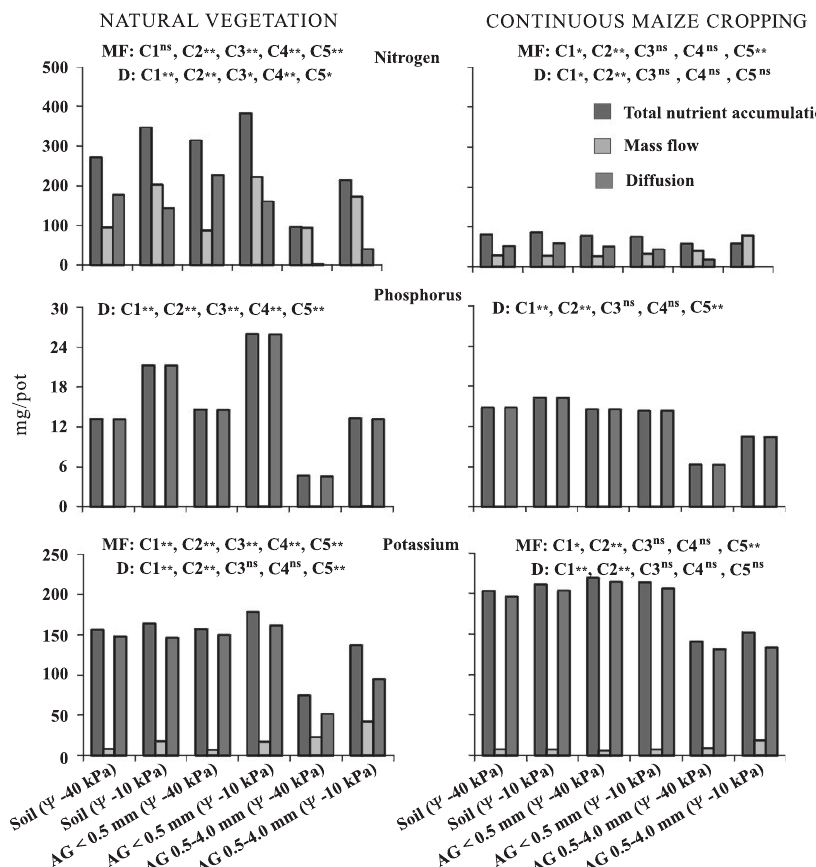
Figure 1. Total nitrogen, phosphorus and potassium accumulation in maize plants and quantities supplied by mass flow (MF) and diffusion (D), considering the material used for testing, soil or aggregates (AG), the water potential ( ΨΨΨΨΨ ) and the management system. Natural vegetation or continuous maize cropping. C : soil vs. AG. C : AG < 0.5 mm vs. AG 0.5–4.0 mm. C 1 2 respectively, by the F